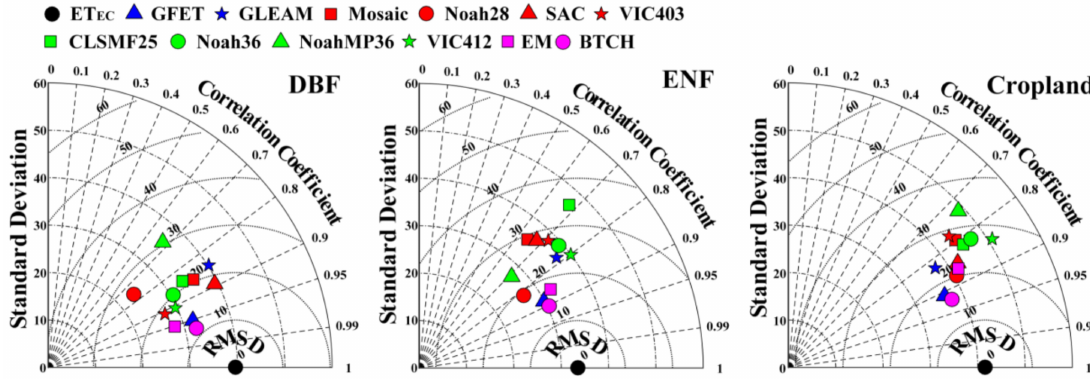
Figure 4. Comparison of monthly BTCH-integrated, ensemble mean (EM), and ten parent evapotranspiration (ET) datasets with flux tower observations. There are 144, 336, and 300 samples for the deciduous broadleaf forest (DBF), evergreen broadleaf forest (ENF), and cropland, respectively. ET WB values are also used to assess the accuracy of ET estimates from BTCH, EM, and ten